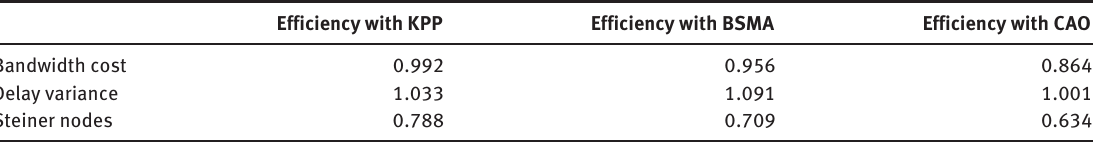
Table 5. Efficiency of the Proposed Method.